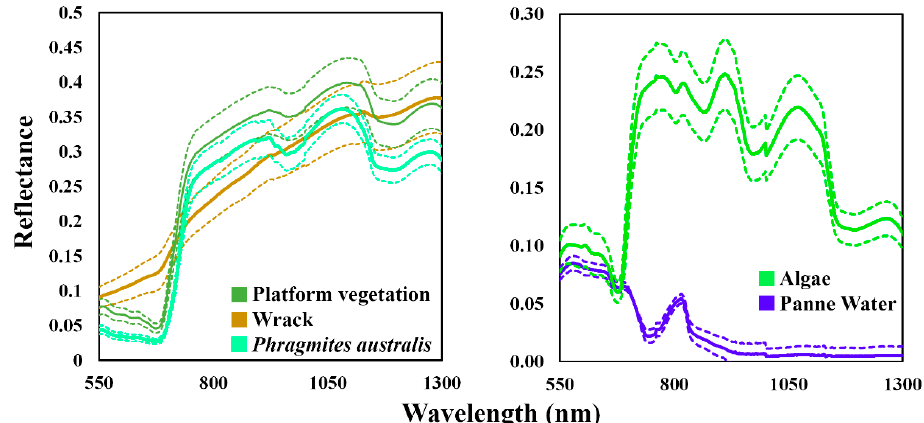
Figure 4. Spectral signatures of saltmarsh components collected with ASD FieldSpec spectrometer on the ground during August 28th 2015, the day of a Landsat 8 overpass of the study site. Solid lines are the mean of collected spectra. Dashed lines are the 95% confidence intervals.